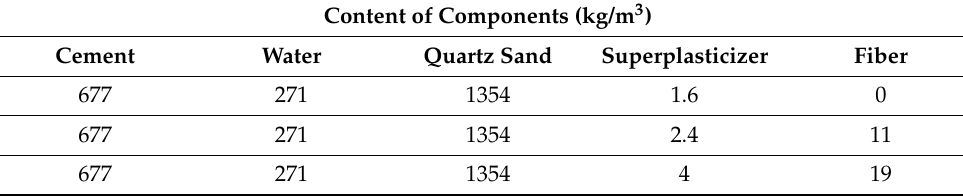
Table 5. Composition of concrete mixture with untreated fiber.